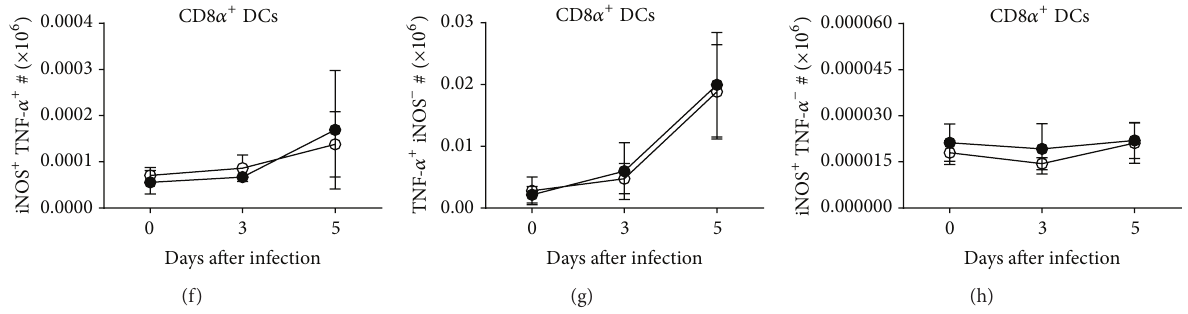
Figure 4: MIF induces TipDCS during acute T. gondii infection. CD11b + and CD8 𝛼 + DCs from WT ( I ) and Mif −/− ( e ) were analyzed for intracellulariNOSandTNF- 𝛼 productionat0,3,and5daysafterinfection.(a)RepresentativedotplotsfromiNOS/TNF- 𝛼 -producingCD11b + (TipDCs). (b) Absolute numbers of iNOS + TNF- 𝛼 + , (c) TNF- 𝛼 + iNOS − , and (d) iNOS + TNF- 𝛼 − cells from CD11b + DCs. (e) iNOS/TNF- 𝛼 - producing CD8 𝛼 + DCs. (f) Absolute numbers of iNOS + TNF- 𝛼 + , (g) TNF- 𝛼 + iNOS − , and (h) iNOS + TNF- 𝛼 − cells from CD8 𝛼 + DCs during the acute phase of infection with T. gondii ( 𝑛 = 3 animals at each time point, representative of 2 independent experiments). Data are presented as the mean ± SE. ∗ 𝑃 < 0.05 ; ∗∗ 𝑃 < 0.01